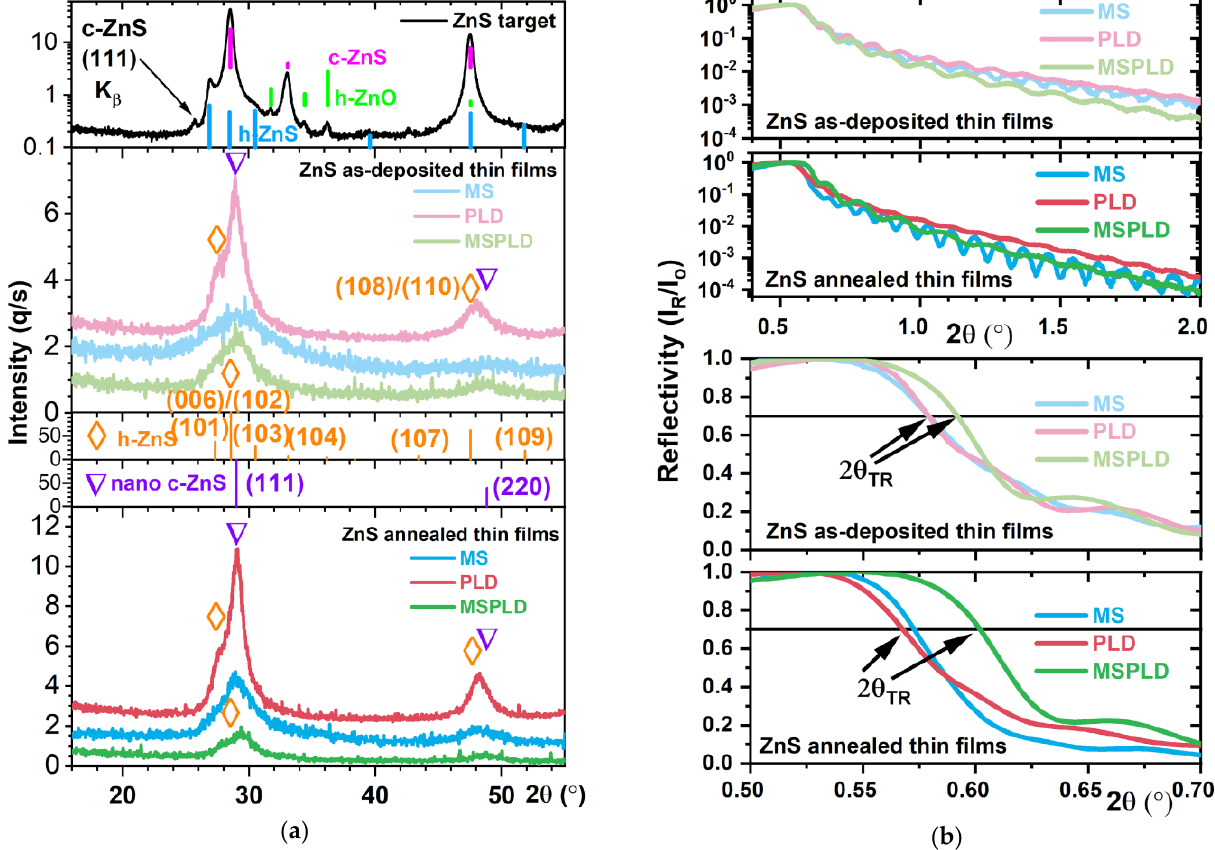
Figure 1. Grazing incidence X-ray diffraction patterns ( a ) and X-ray reflectivity diagrams ( b ) for the ZnS thin films obtained by MS, PLD, and MSPLD, in the as-deposited state and annealed at 400 °C. Additionally, the GIXRD diagram of the ZnS target and the ICDD files # 00-005-0566 (cubic ZnS, F-43m (216) space group), # 00-036-1450 (hexagonal ZnS, P63mc (186) space group) and # 04-003-2106 (hexagonal ZnO, P63mc (186) space group) are presented. The positions of the total reflection edge ( 2 θ TR ), defined as the angle where the reflectivity decreases by 30% of the maximum, are indicated. The GIXRD patterns are displaced vertically for a better representation. Table 2. The crystalline phases in the three types of ZnS thin films. The average size of the crystallites was approximated using Scherrer equation for the (111) c-ZnS peak.